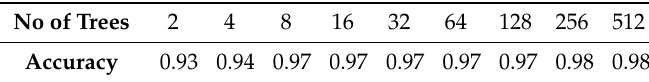
Table 2. Performance evaluation with different number of